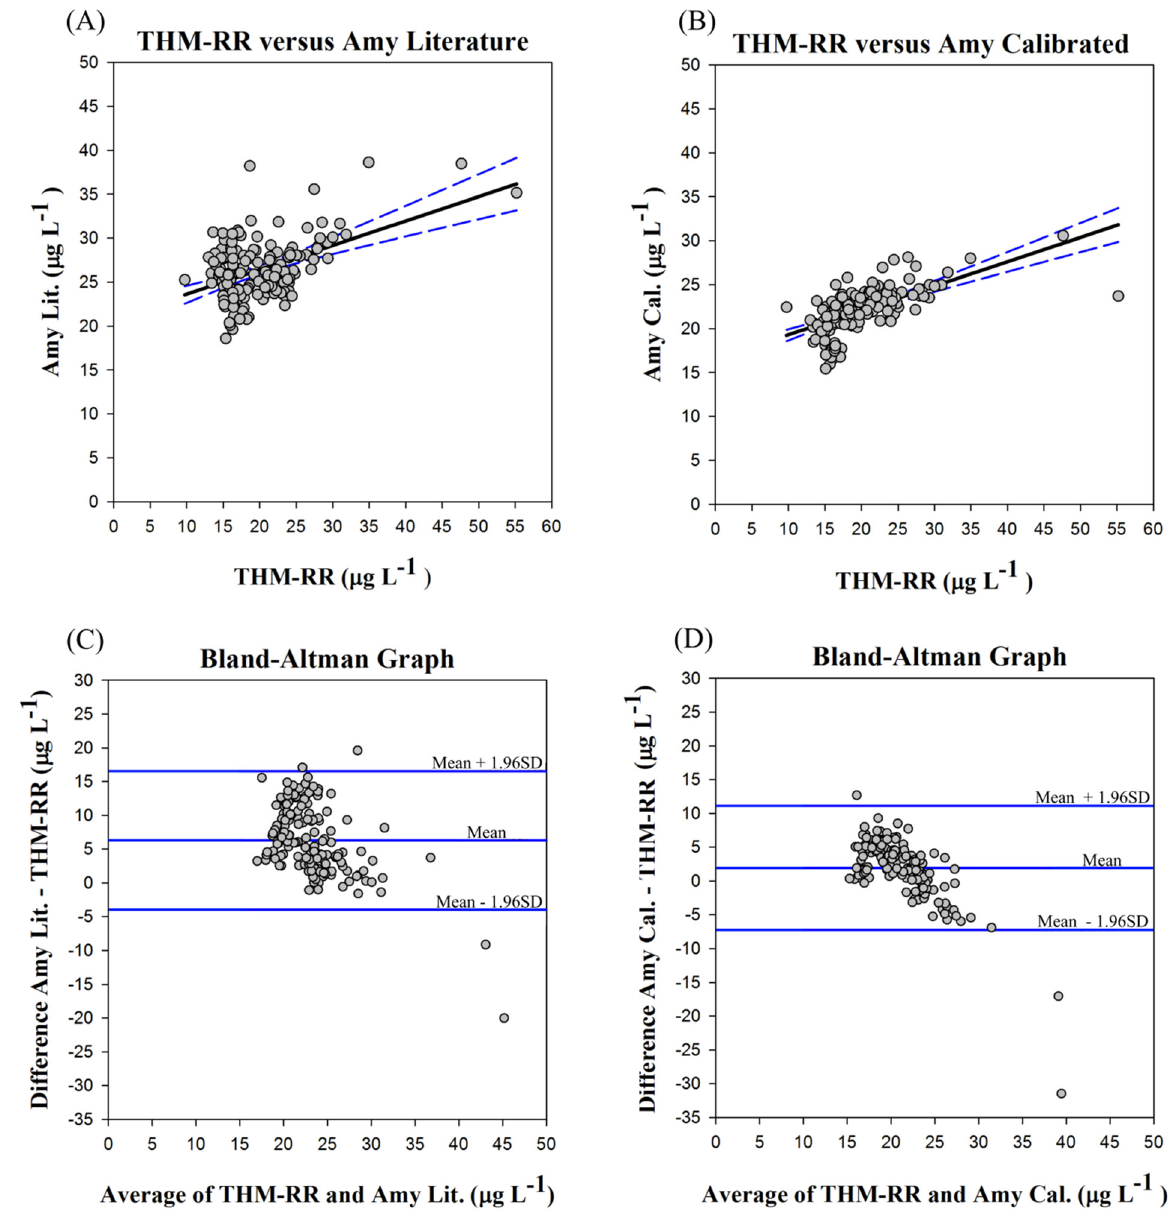
Figure 7. Bland-Altman Plots for the Amy literature and calibrated models for the period of 23 June 2014 through 16 December 2014. ( A ) Amy Literature generated Total THMs concentrations vs. THM-RR measurements; ( B ) Amy Calibrated generated Total THMs concentrations vs. THM-RR measurements; ( C ) Difference plot for the Amy Literature model and THM-RR measurements of Total THMs; ( D ) Difference plot for the Amy Calibrated model and THM-RR measurements of Total